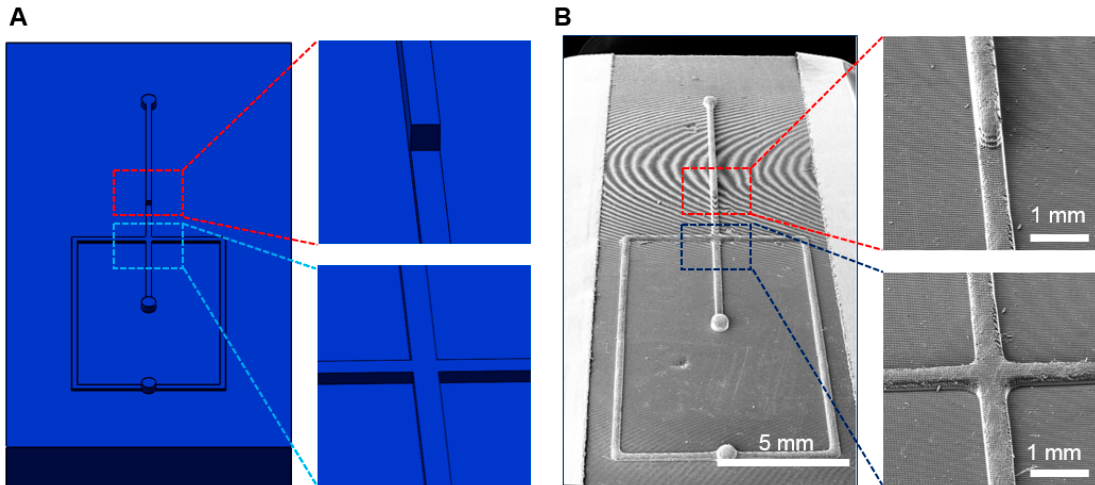
Figure 6. Mold design and fabrication of the flow-focusing droplet generator with multi-depth features. ( A ) Solid model of the mold for printing. ( B ) SEM pictures of the printed mold. Zoom-in images show the details of the multi-depth channel and the flow-focusing junction.